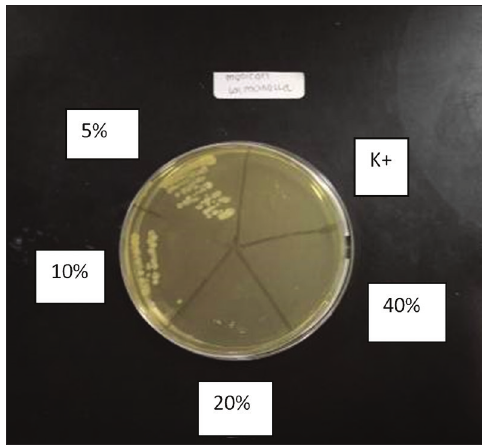
Figure-3: Results of dilution in Meniran extract.